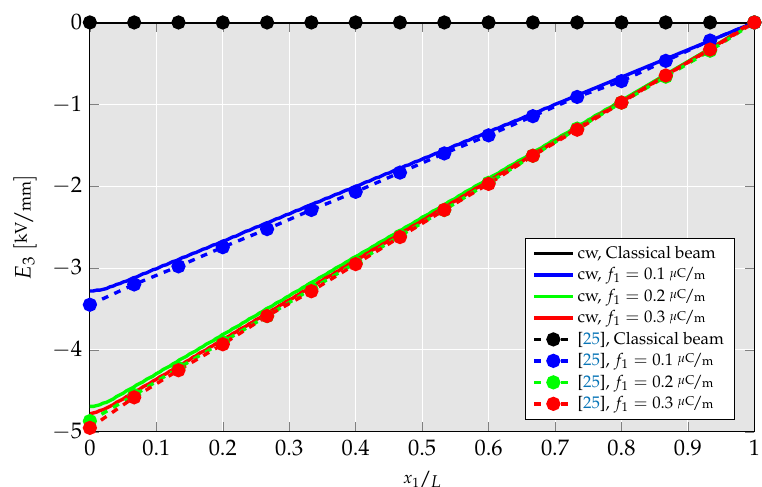
Figure 8. Comparison of electric field of the cantilever beam between the results given in the literature and of the current work by using linear element for different flexoelectric coefficients f 1 . cw denotes the current work.